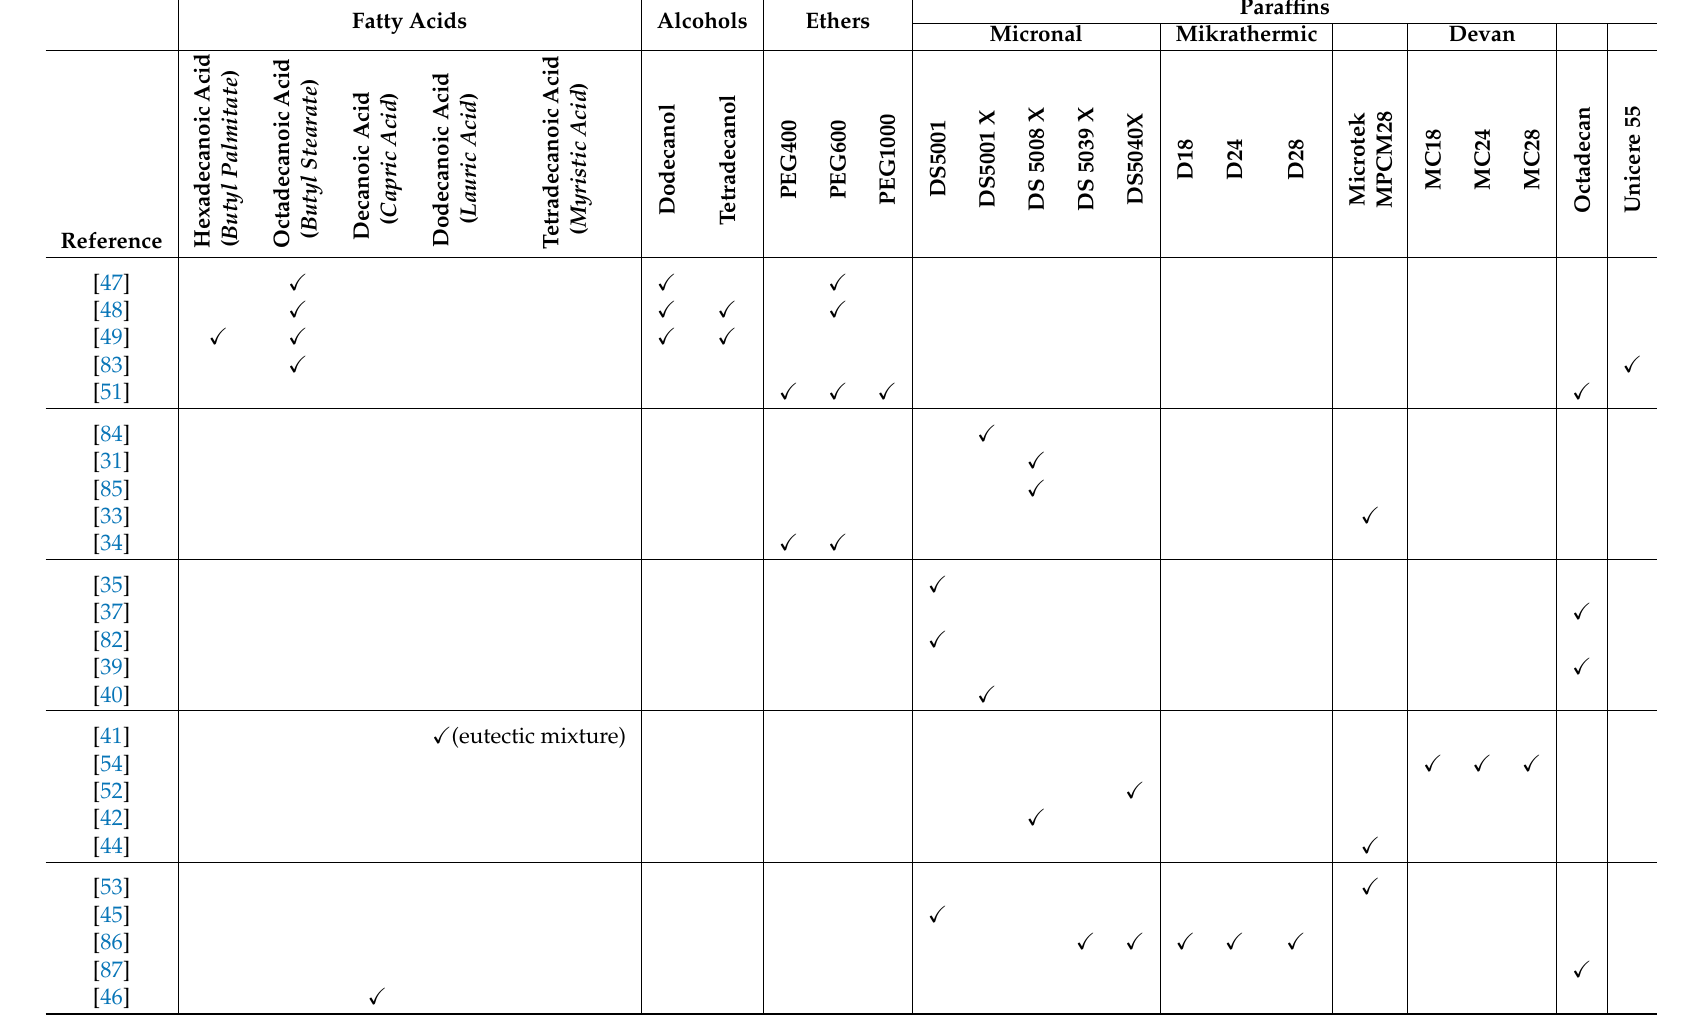
Table 4. Overview of the phase change material (PCM) possibilities for use in combination with mortars. Fatty Acids Alcohols Ethers